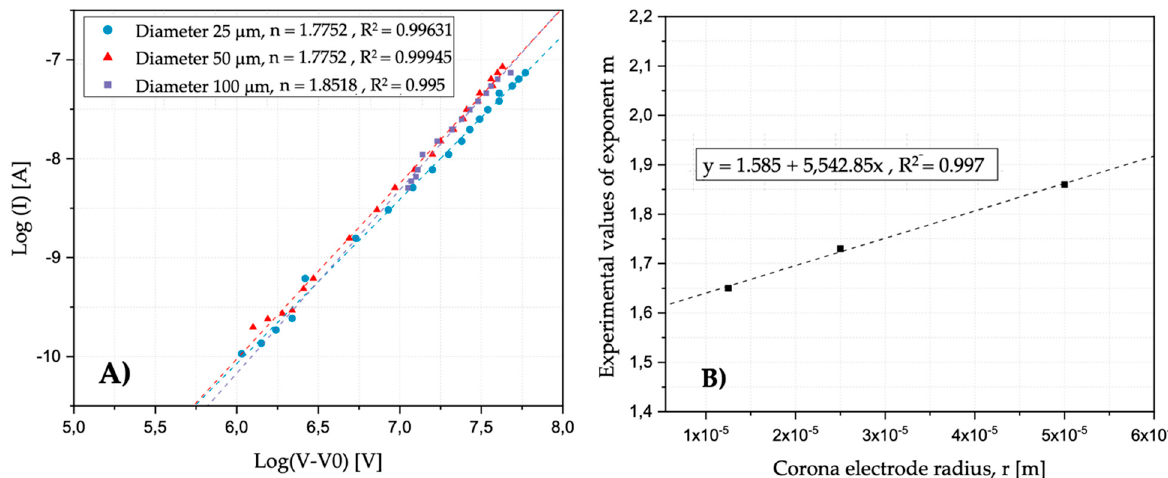
Figure 8. Linear relationship between ( A ) log I and log (V − V 0 ) and ( B ) the exponent m and the diverse radii of the corona wire.